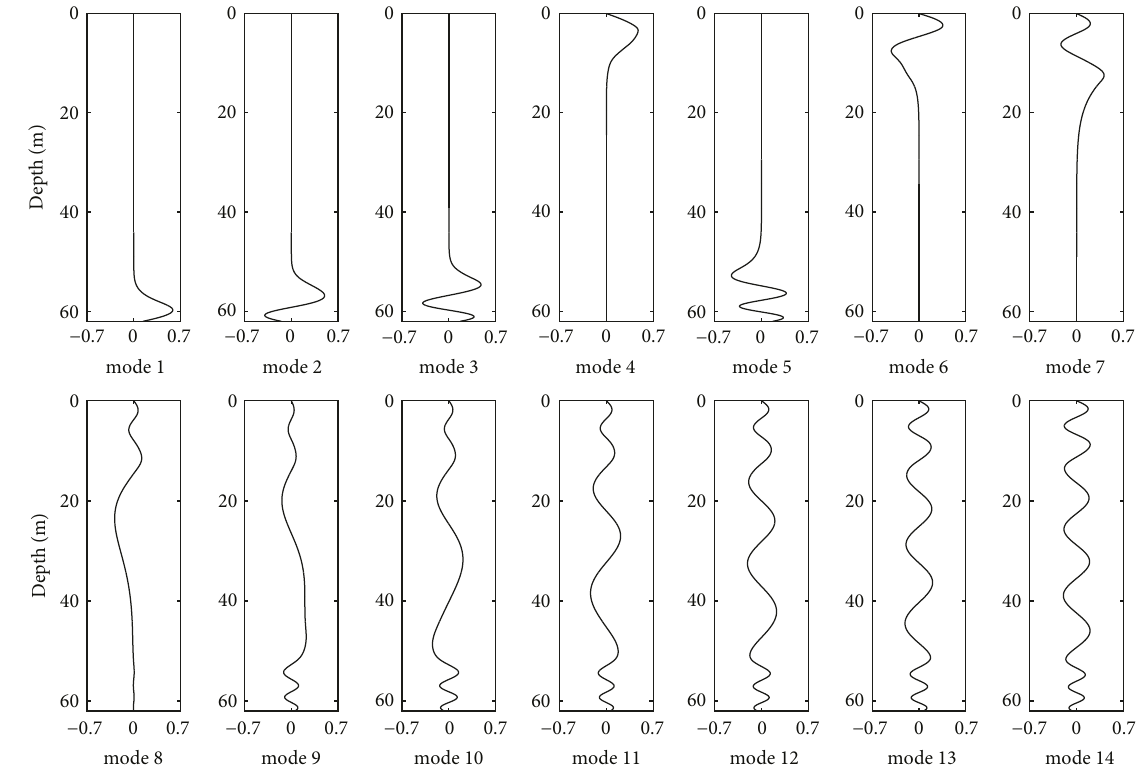
Figure 9: Mode amplitudes for Case